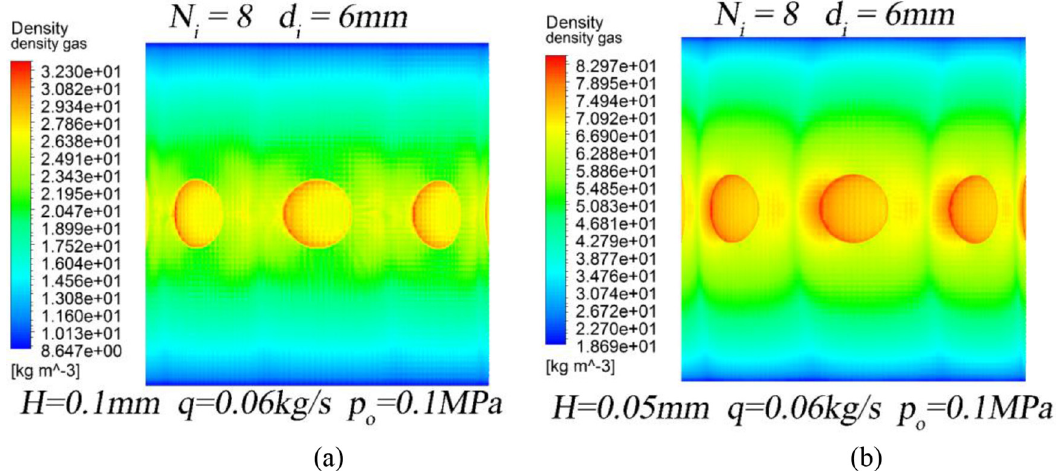
Fig. 13. Comparison of the density distribution between H=0.1mm and H=0.05 mm. (a) H=0.1 mm. (b) H=0.05